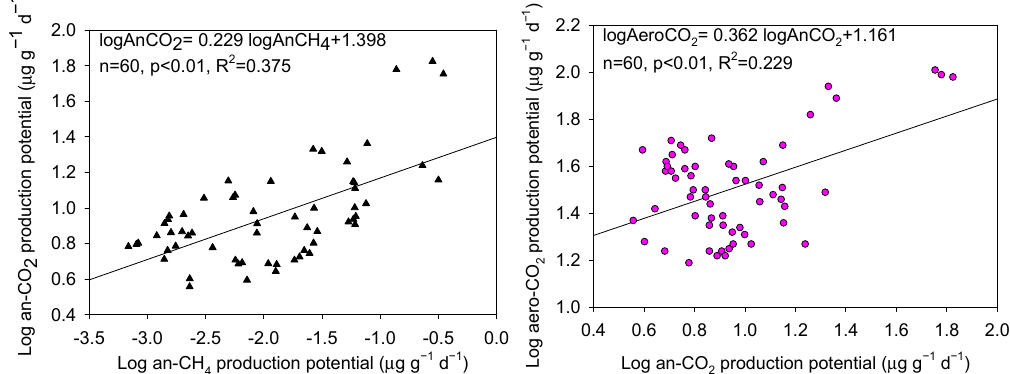
Figure4. TherelationshipsbetweenanaerobicCO 2 productionpotentialsandanaerobicCH 4 production Figure 4. The relationships between anaerobic CO 2 production potentials and anaerobic CH 4 potentials ( left ), and aerobic CO 2 production potentials ( right production potentials ( left ), and aerobic CO 2 production potentials ( right ).